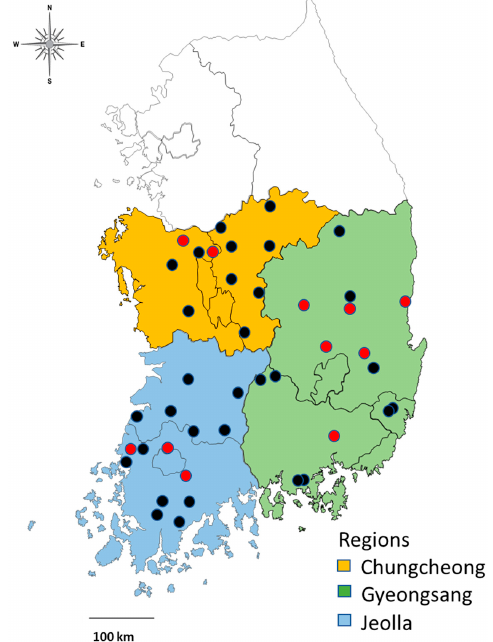
Figure 1. Study area, including tick collection sites in the central and southern regions of Korea (March–July 2021). Three study regions are indicated by different colors based on the administrative district boundaries (Chungcheong, yellow; Gyeongsang, green; Jeolla, blue). Tick collection sites are indicated by black circles, and sites PCR-positive to Borrelia by red circles.